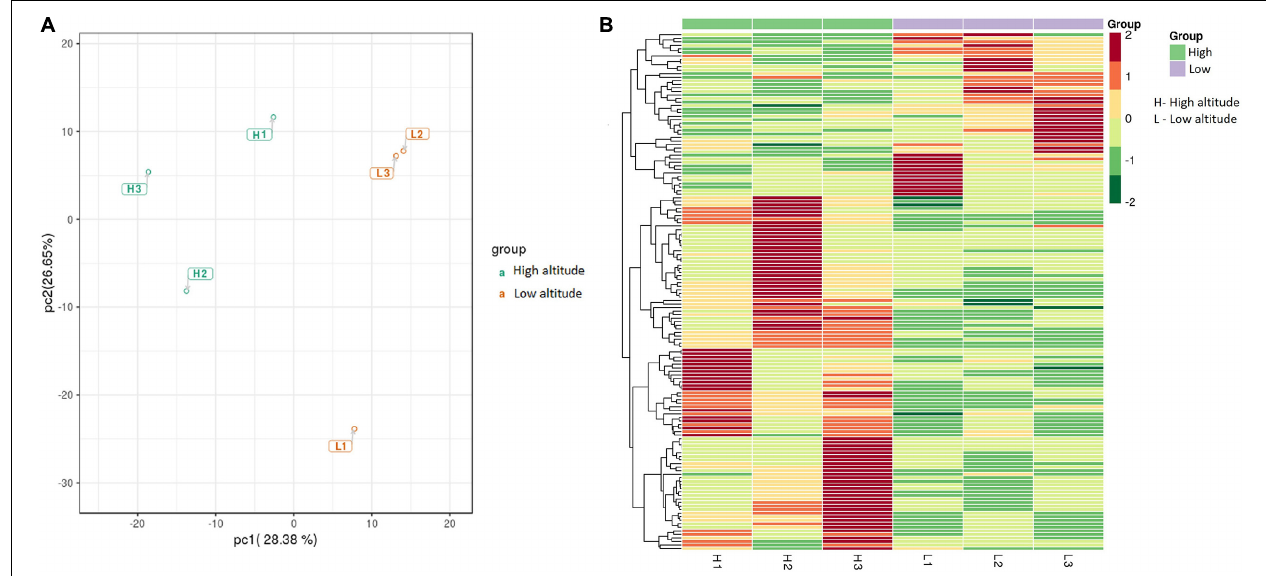
FIGURE 2 | Principal component analysis (PCA) (A) and heatmap (B) of differentially accumulated metabolites (DAMs) in the leaves of Cyclocarya paliurus between low altitude (L1 ∼ L3) and high altitude (H1 ∼ H3). The log 2 transformed values of DAMs are indicated from green to red (low to high).